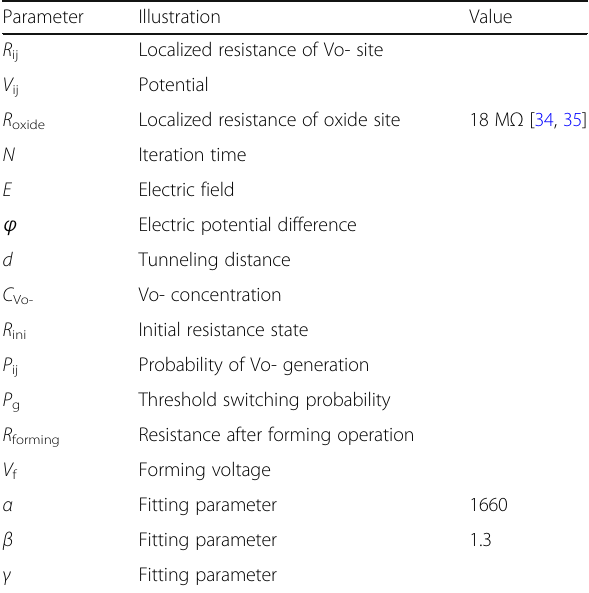
Table 1 Simulation parameter for imitating the behavior of trap-assisted tunneling and Vo- generation process of forming